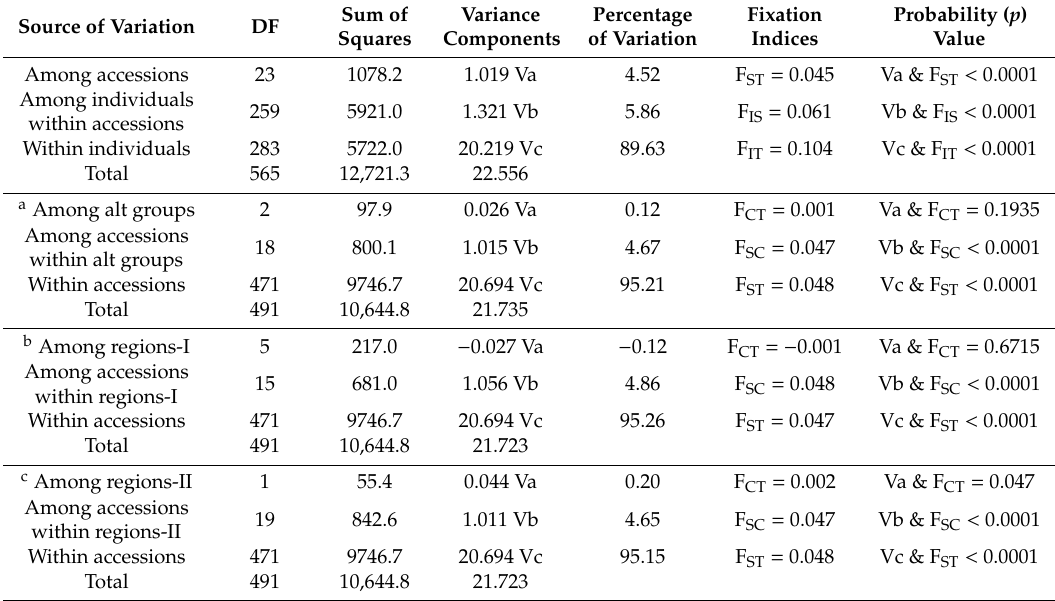
Table 3. Analysis of molecular variance (AMOVA), based on 1023 permutations, for 24 accessions without grouping, and for 21 accessions by grouping them according to altitudinal range or regions of